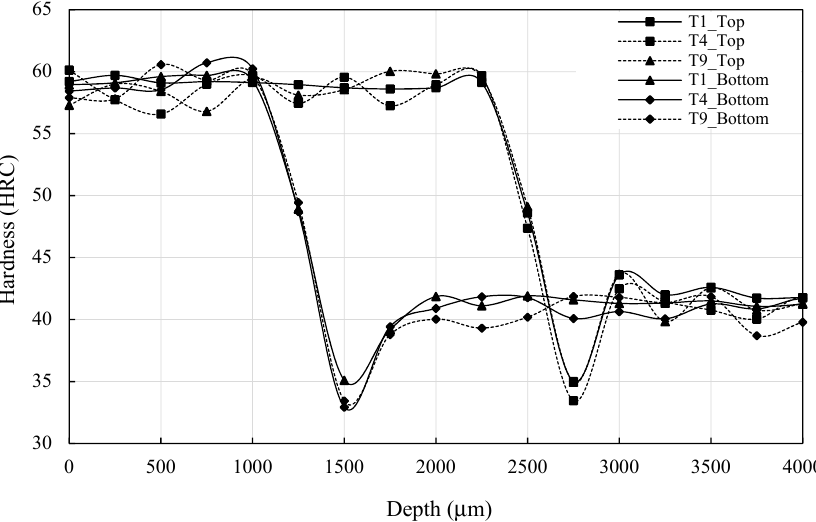
Figure 9. Typical hardness curves at gear teeth top and bottom vs. depth for tests T 1 , T 4, and T 9 .